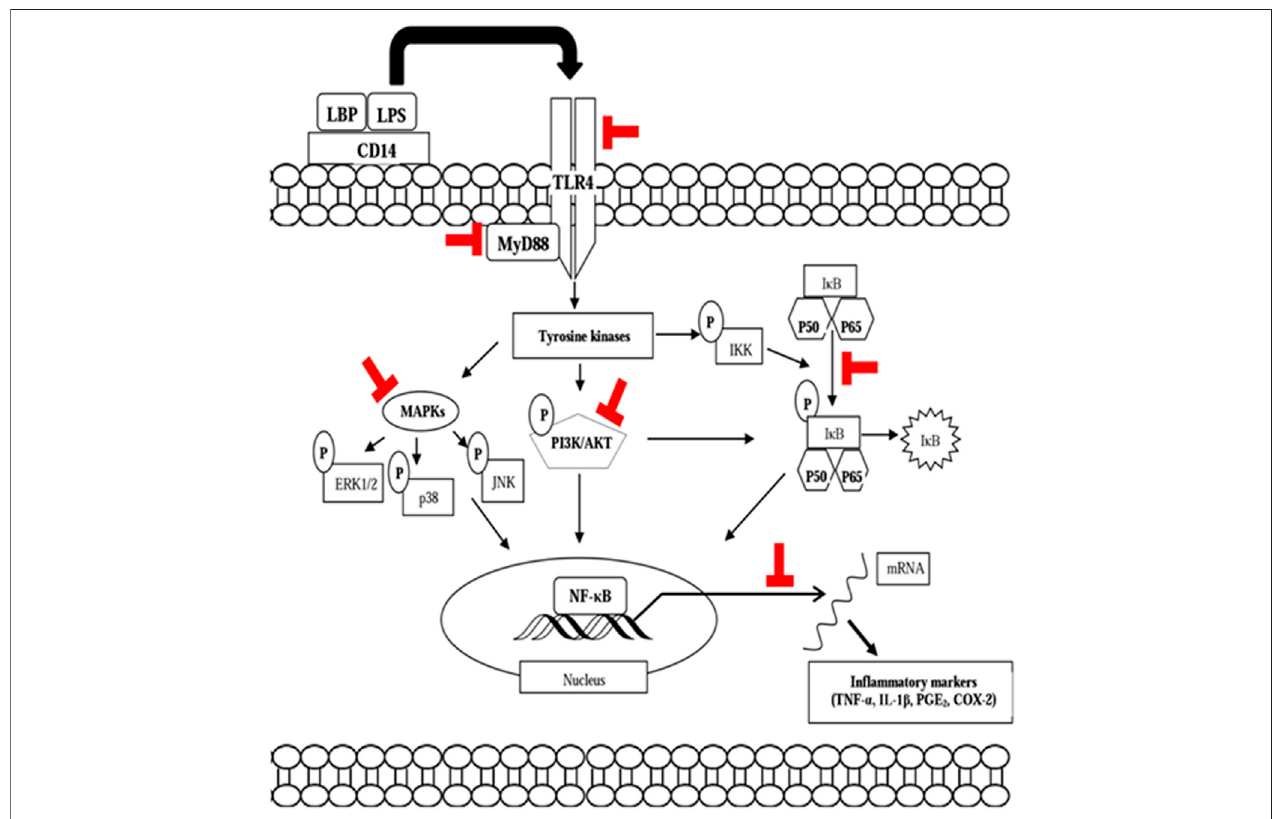
FIGURE3| ModulatoryeffectsofcurcuminontheNF- κ B,MAPK,andAktsignalingpathways.Thethickredblocksignindicatesthepossiblepointofmodulationof thesignaltransductionpathways.NF- κ B,nuclearfactorkappa β ;MAPK,mitogen-activatedproteinkinase;PI3K/Akt,phosphatidylinositol3-kinaseandproteinkinaseB; P, phosphoryl